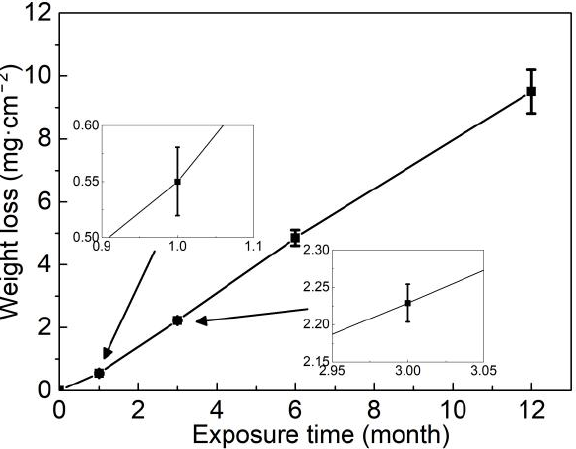
Figure 4. The weight loss of AZ31 magnesium alloy in the marine atmospheric environment during ocean voyage.